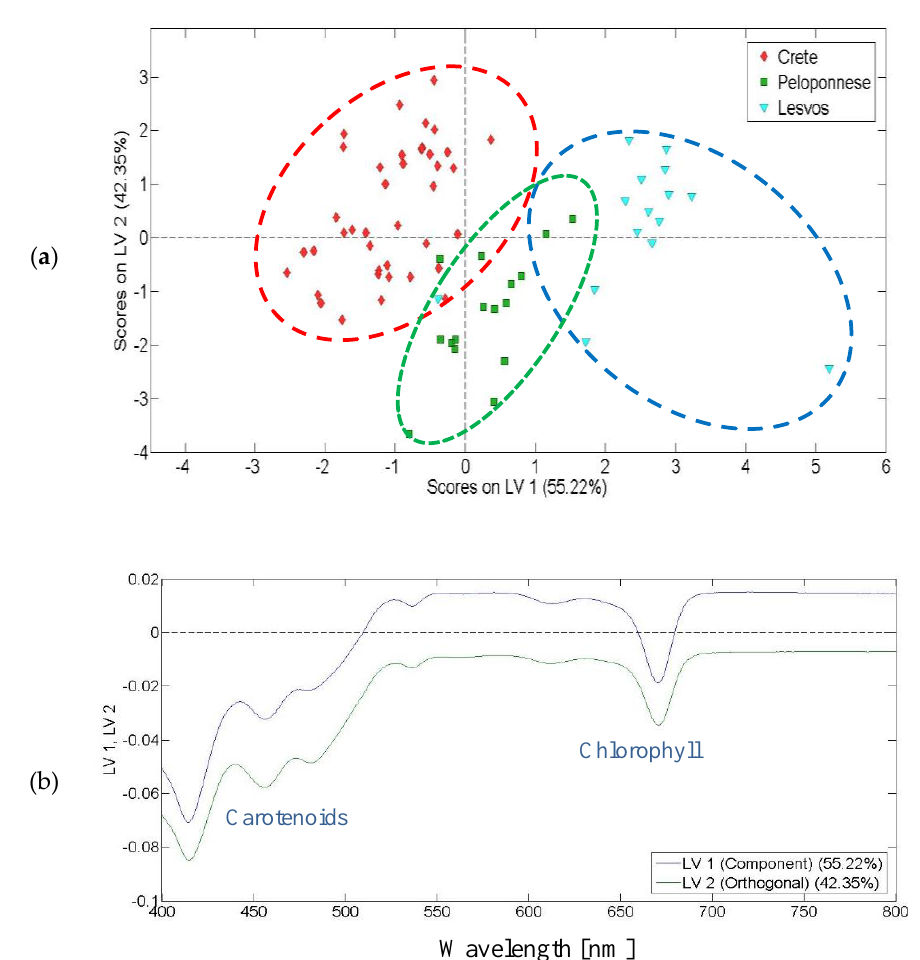
Figure 3. Classification of olive oils: ( a ) score plot for the discrimination of the olive oils from Crete, Peloponnese and Lesvos using visible absorption spectroscopy; ( b ) loading plot based on visible spectra.